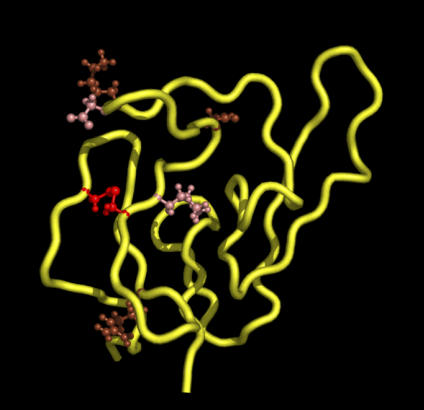
Epitope Mapping of JS1 and JS2 Binding SitesShows the location in the three-dimensional model of P. falciparum MSP119 of residues in the first epidermal growth factor domain, which on mutation affect binding by JS1 or JS2. Mutation of Cys28 shown in red completely ablated binding of both mAbs (12.10 and 12.8) and JS1 or JS2. Mutation of the partnering Cys12, also shown in red, while ablating binding by the murine mAbs, had no effect on the binding by JS1 or JS2. Arg20 and Asn33 in salmon had intermediate effects on binding as determined by SPR analysis when mutated to more neutral or negatively charged side-chains (see Table 1). Three further substitutions at Lys40, Lys29, and Asn39 seen in brown had minor effects on binding when the interaction was studied by ELISA. The model of P. falciparum MSP119 was generated by PyMol using atomic coordinates available from NCBI under accession number PDB: 1CEJ.